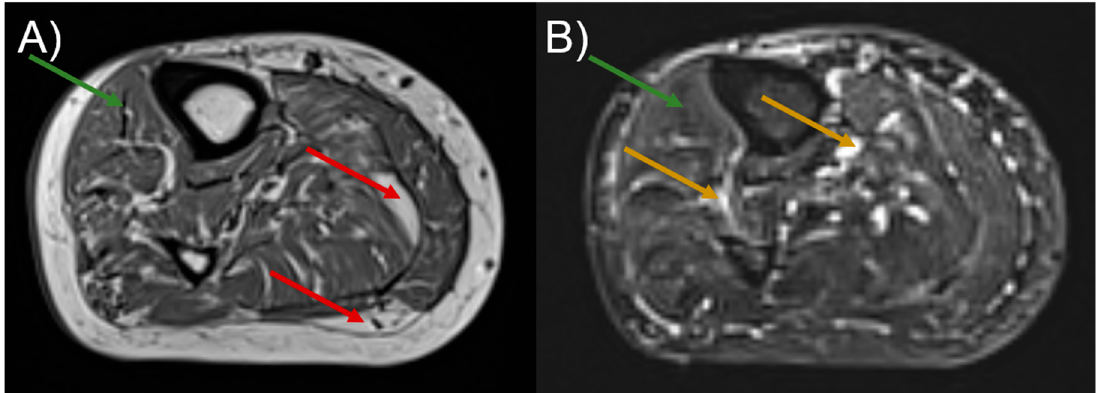
Figure 2. T 1 -weighted ( A ) and T 2 -weighted ( B ) images of the patient’s calf acquired before the intervention (following the E1 diffusion tensor imaging (DTI) examination). Red, green and yellow arrows indicate fatty accumulation in muscles, fibrosis and blood vessels, respectively.